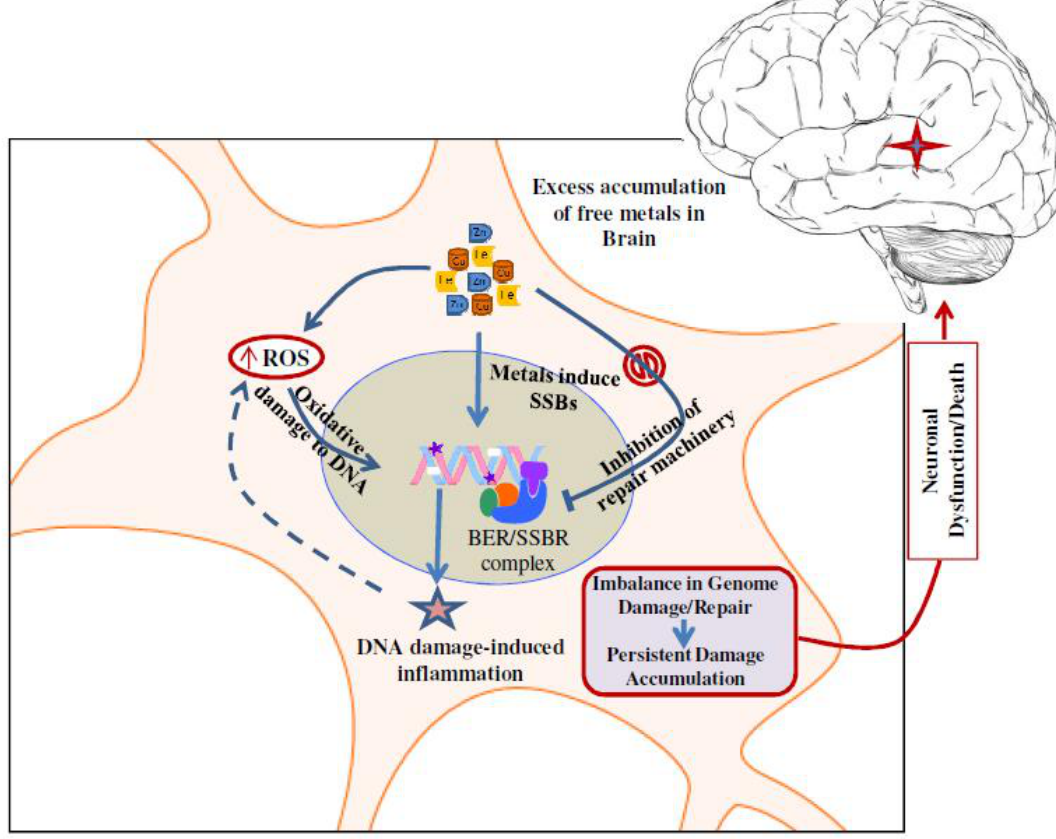
Figure 2. The genotoxicity of metals in neuronal cells: a ―double-whammy‖. Excess accumulation of metals in neurons not only causes increased oxidative damage to the genome, both directly and via ROS, but also inhibits the repair of such damage by binding/oxidizing certain repair proteins. This creates an imbalance between genome damage and repair, and the resulting persistent accumulation of damage contributes to neuronal dysfunction and cell